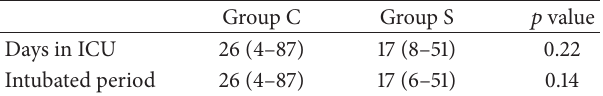
Table 3: Patients